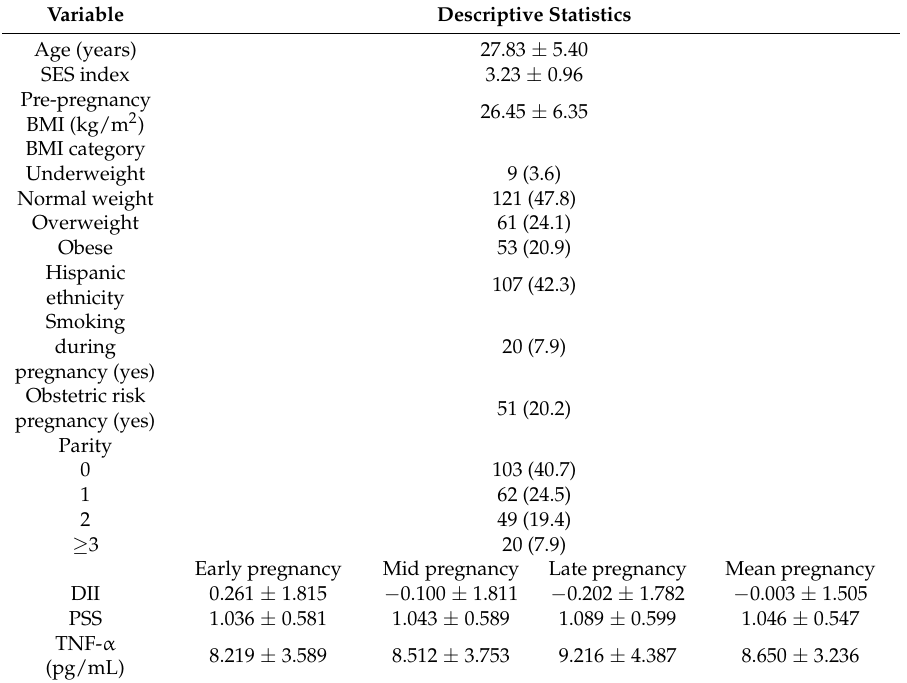
Table 1. Maternal sociodemographics, DII, PSS, and TNF- α levels across pregnancy. Variable Descriptive